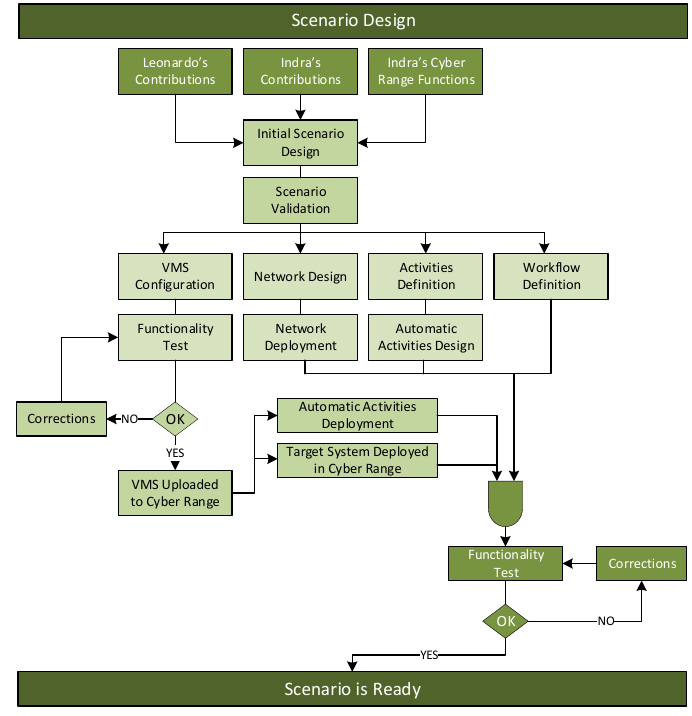
Figure 2. Workflow for scenario